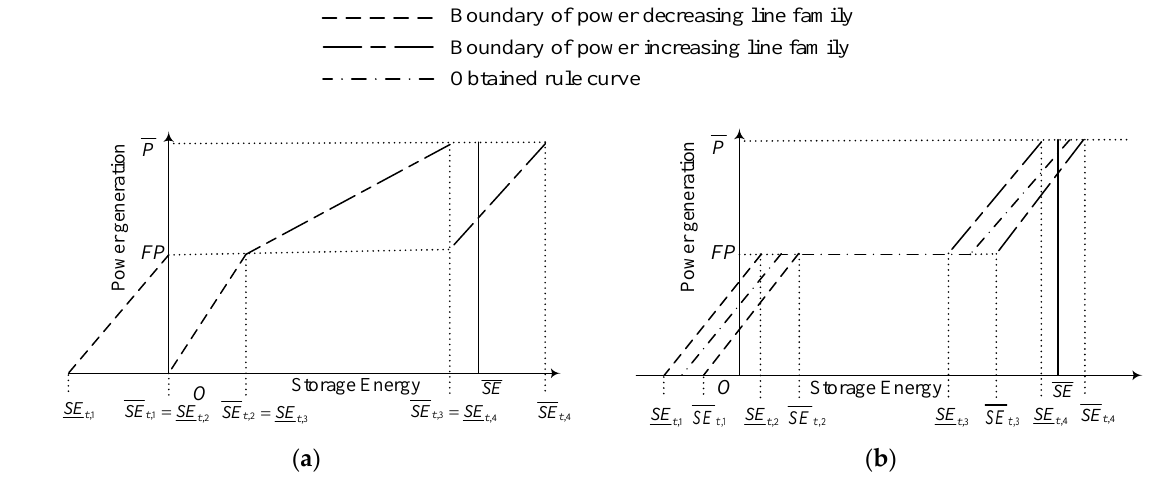
Figure 2. Feasible region change. ( a ) Initial feasible region division, and ( b ) second round optimization feasible region division.